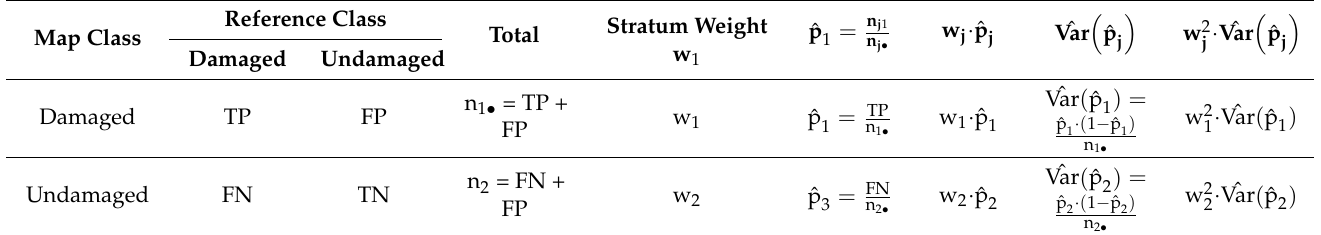
Table 1. Confusion matrix and estimators.